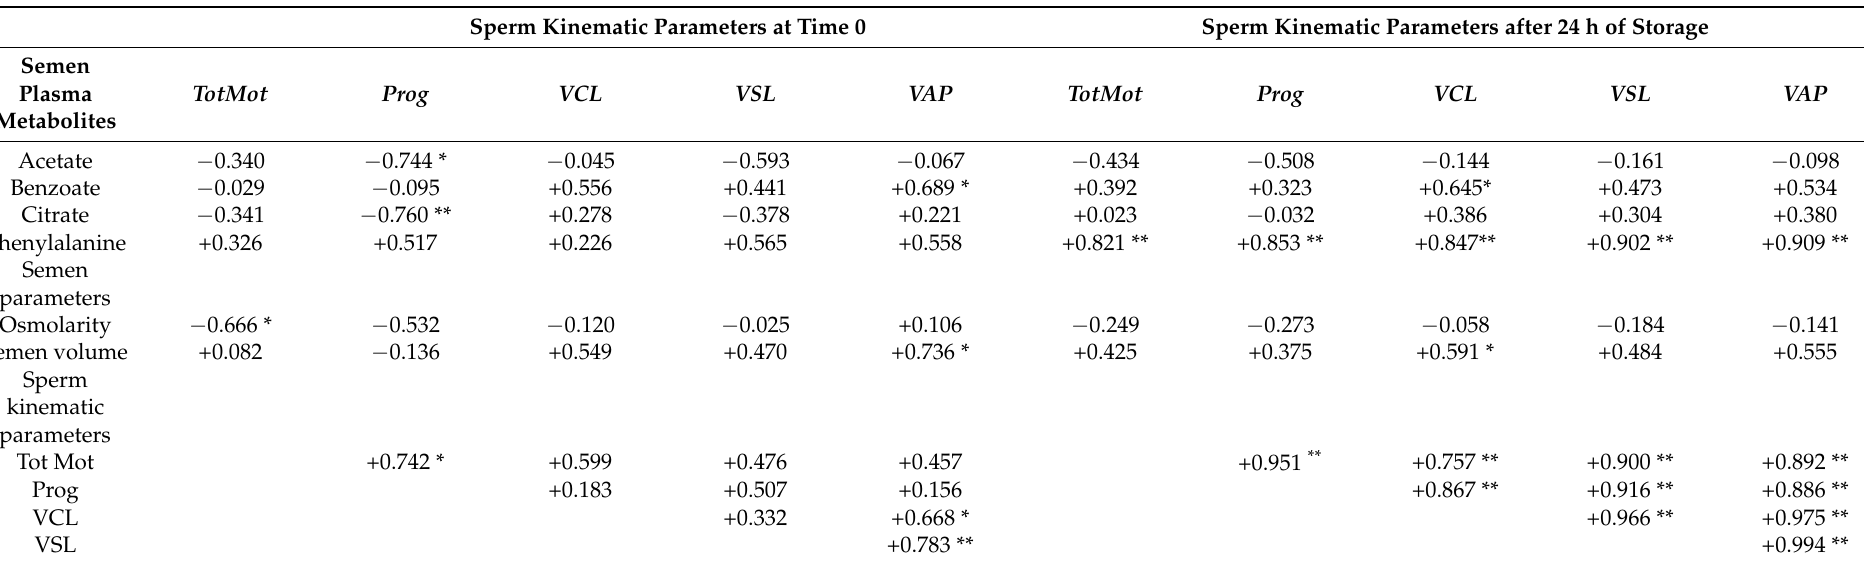
Table 5. Correlation coefficients (R) between seminal plasma metabolites and sperm kinematic parameters evaluated in the nine donkey stallions at the time of semen collection and after 24 h of storage at 4 ◦